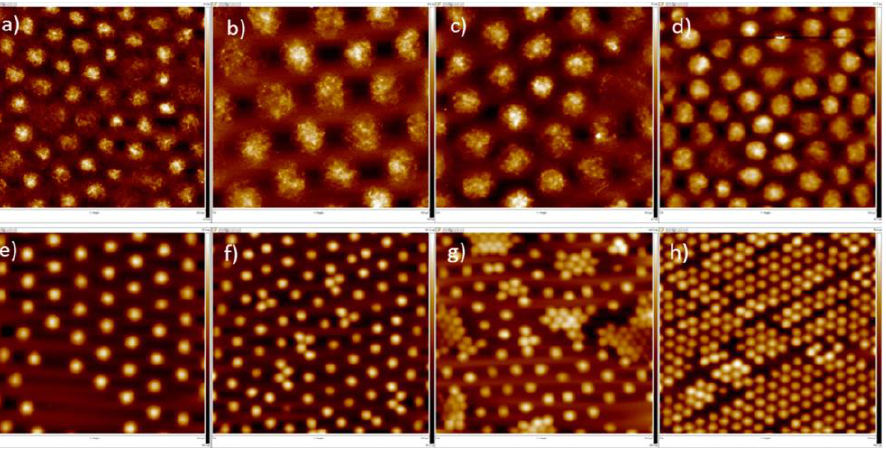
Figure 4. Atomic Force Microscopy images of Langmuir – Blodgett deposits obtained from low cross- linked ( a – d ) and high cross-linked ( e – h ) PNIPAM microgels at the water/vapor interface, obtained at increasing values of the interfacial coverage (from left to right). Reprinted from Picard et al. [75] with permission from the American Chemical Society, Copyright (2017).